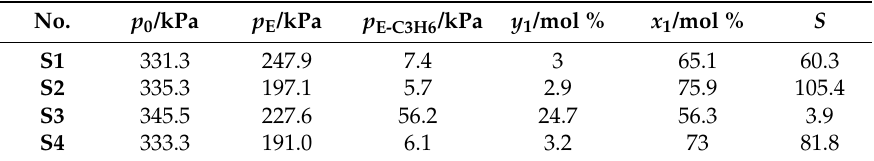
Table 1. Comparison of the separation performance for a C 3 H 6 (1) + H2 (2) gas mixture ( z 1 = 0.35) using a solid ZIF-8 (S1), ZIF-8/water (S2) slurry, ZIF-8/glycol (S3) slurry, or ZIF-8/water-glycol